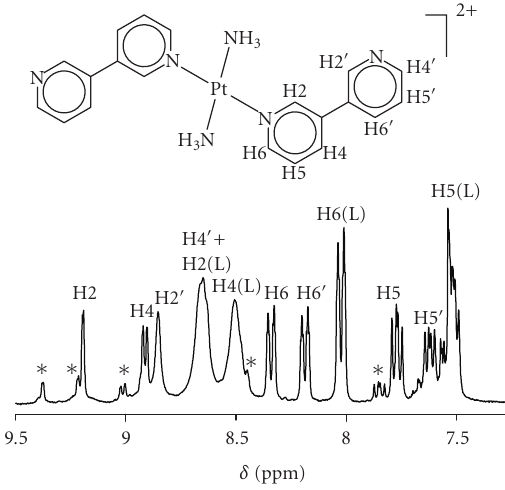
Figure 7: 1 H NMR spectrum of mixture of trans-